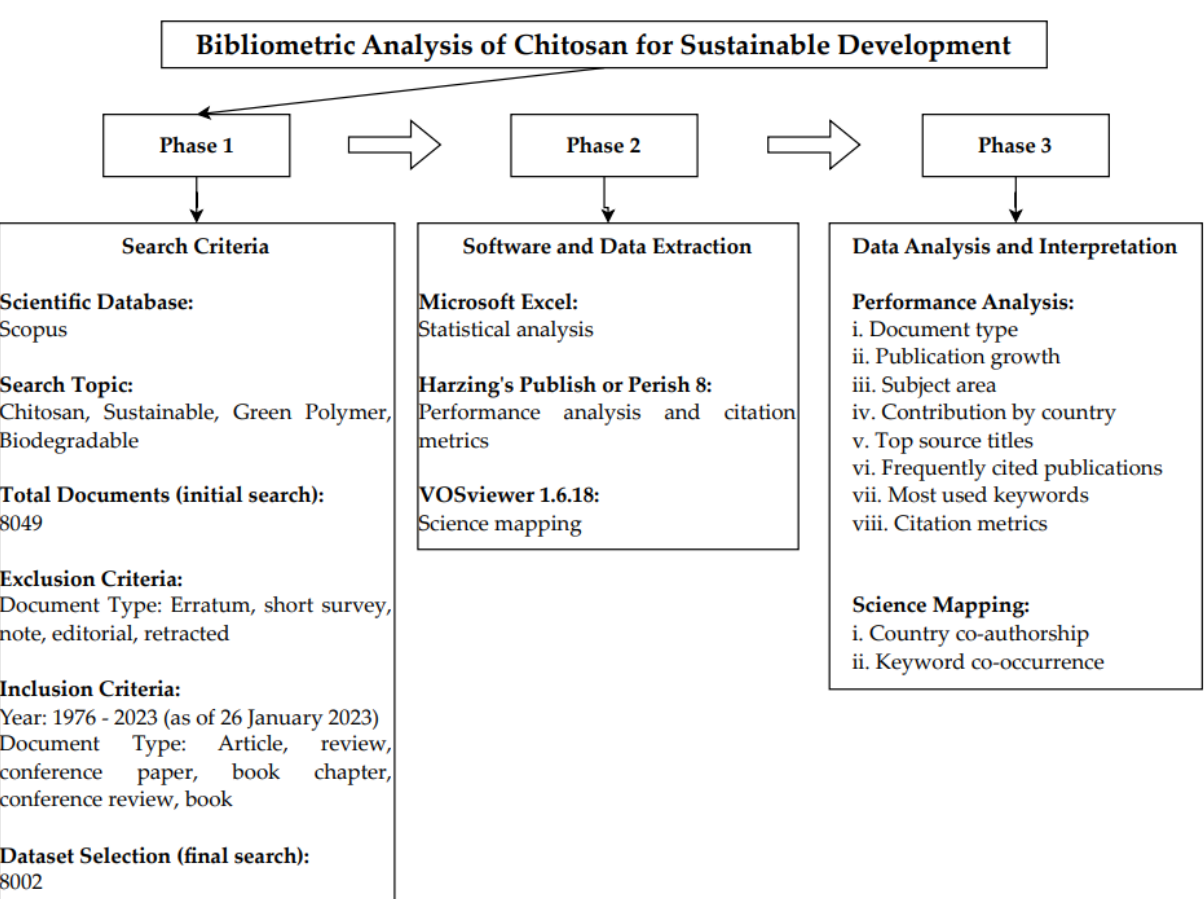
Figure 1. Process of bibliometric analysis of chitosan for sustainable